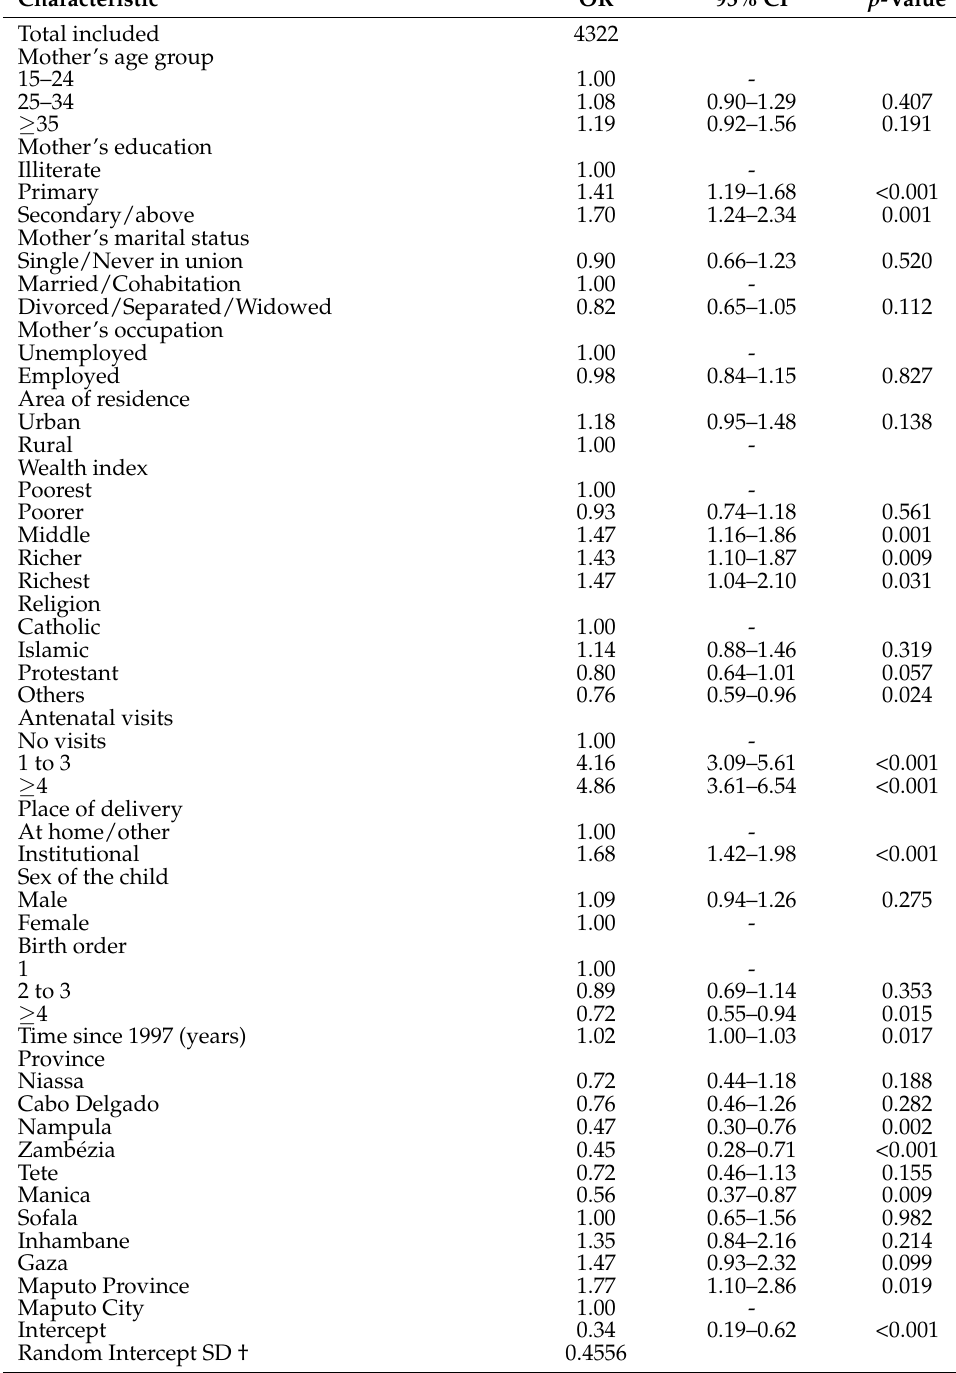
Table 4. Mixed-effect logistic regression of fully immunised children,